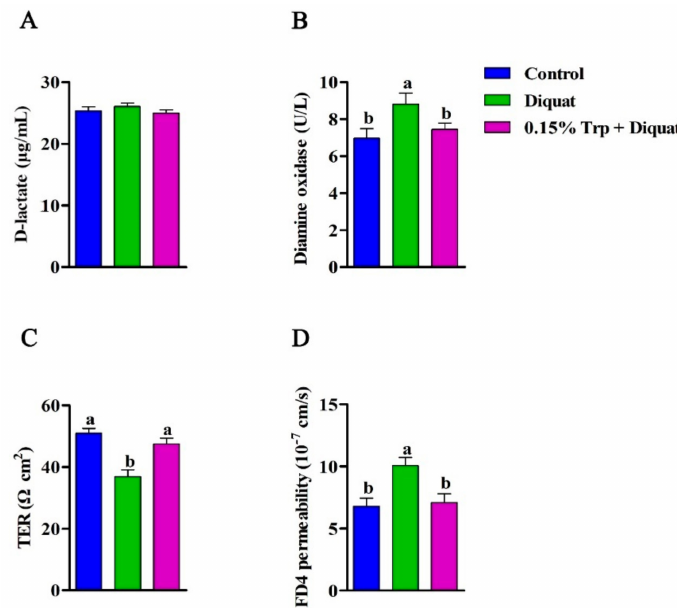
Figure 1. E ff ects of dietary tryptophan supplementation on intestinal permeability of piglets challenged with diquat. ( A ) D-lactate concentration; ( B ) diamine oxidase activity; ( C ) TER, transepithelial electrical resistance; ( D ) the flux of FD4, 4 kDa fluorescein isothiocyanate dextran, at the jejunum. Data are means ± standard error; n = 8 for each group. Mean values sharing di ff erent superscripts within the same row di ff er significantly ( p < 0.05). Control, piglets fed the basal diet without diquat injection; diquat, piglets fed the basal diet and challenged with diquat; 0.15% Trp + diquat, piglets fed the 0.15% supplemented diet and treated with